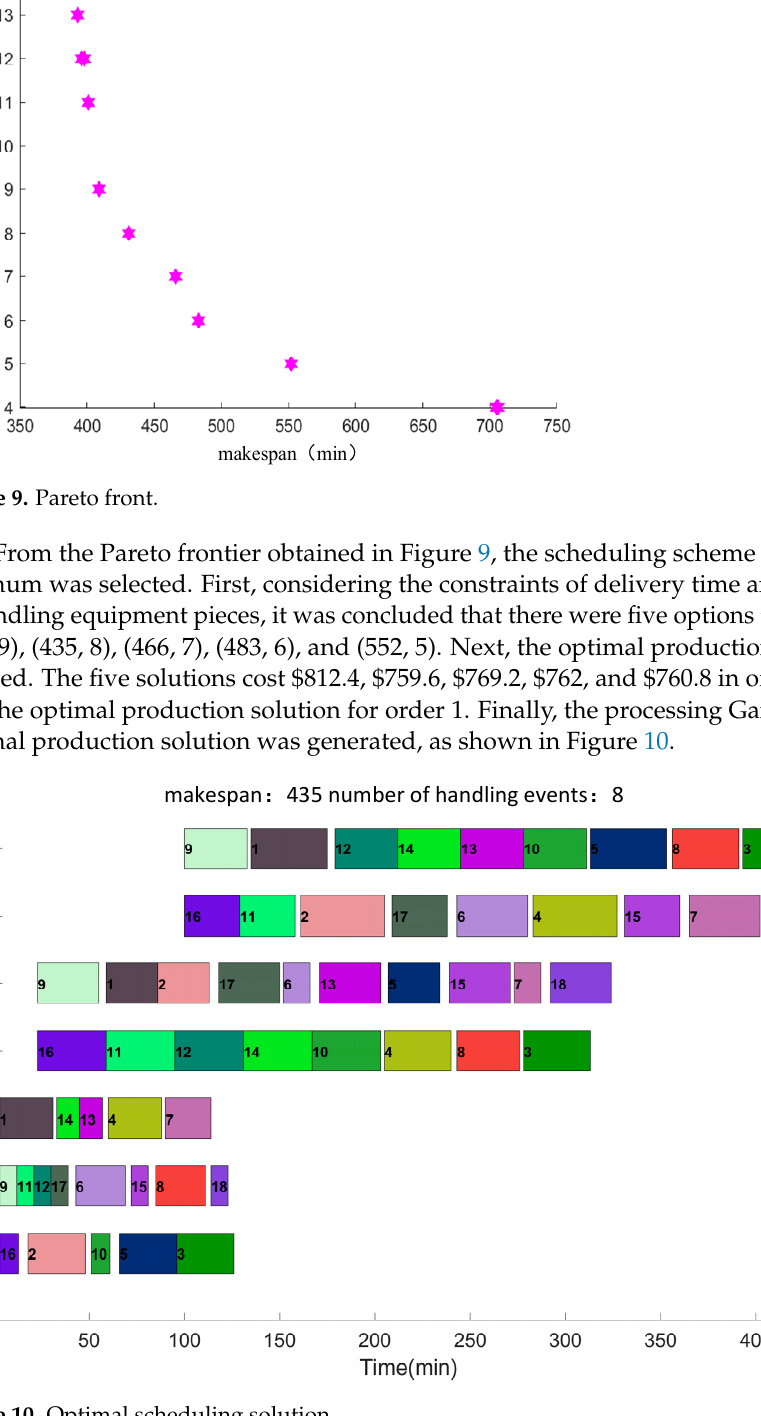
Figure 10. Optimal scheduling solution.